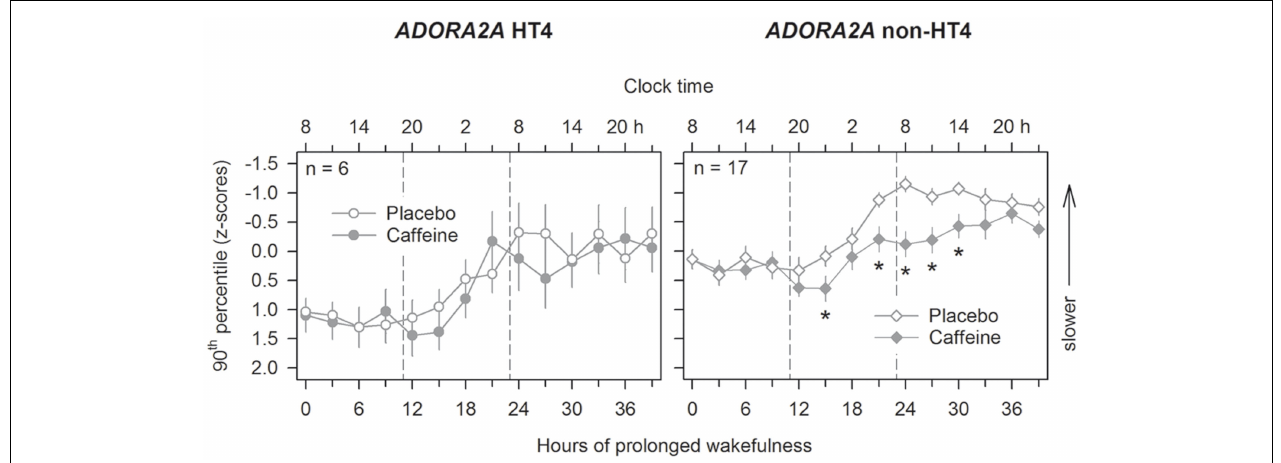
x -axes were rounded to the previous hour. Compared to placebo (open symbols), 2 × 200mg caffeine (filled symbols) improved optimal PVT speed after sleep loss in non-HT4 haplotype carriers only (ANOVA: “haplotype”: F 1,21.2 = 7.91, p < 0.02; “session”: F 13,205 = 13.43, p < 0.0001, “treatment”: F 1,68 = 8.45, p < 0.005; “haplotype” × “treatment” × “session”: F 26,219 = 2.1, p < 0.003). * p < 0.05 (caffeine vs. placebo; two-tailed, paired t